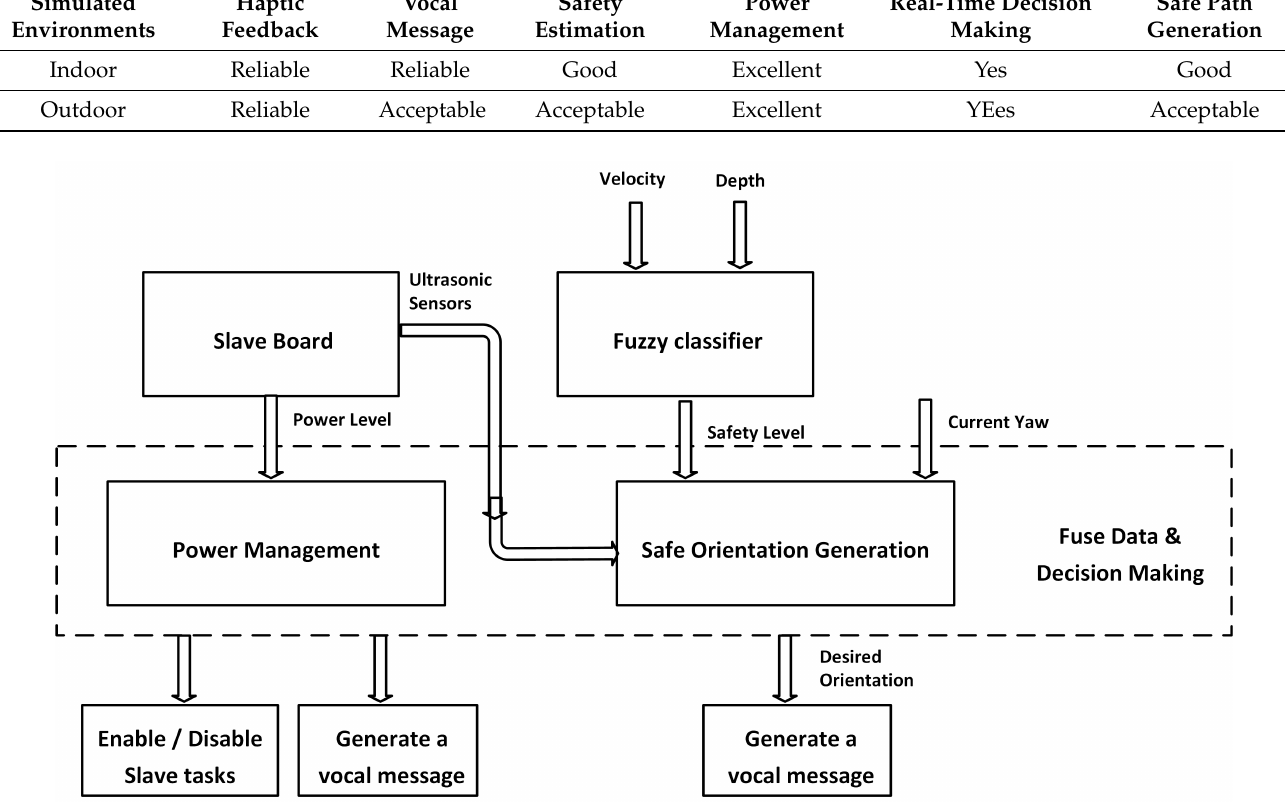
Figure 6. Block diagram of the main